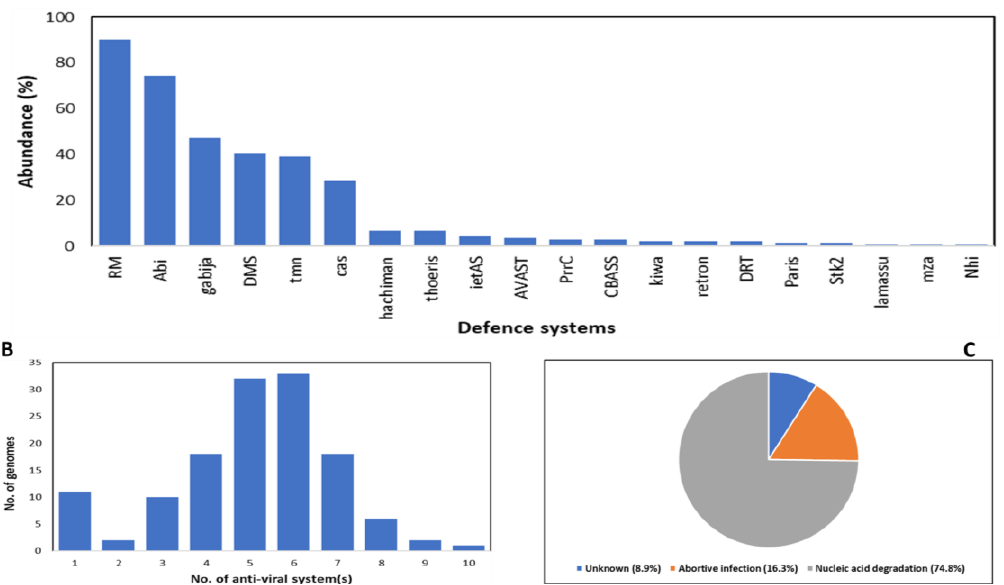
Figure 2. Analysis of anti-viral defence systems detected among 133 publicly available S. suis genomes using PADLOC. ( A ) Abundance of defence systems calculated as the percentage of genomes (out of the total 133) that encode a specific defence system. ( B ) Total number of anti-viral systems per genome. ( C ) Categories of anti-viral systems based on molecular mechanism.